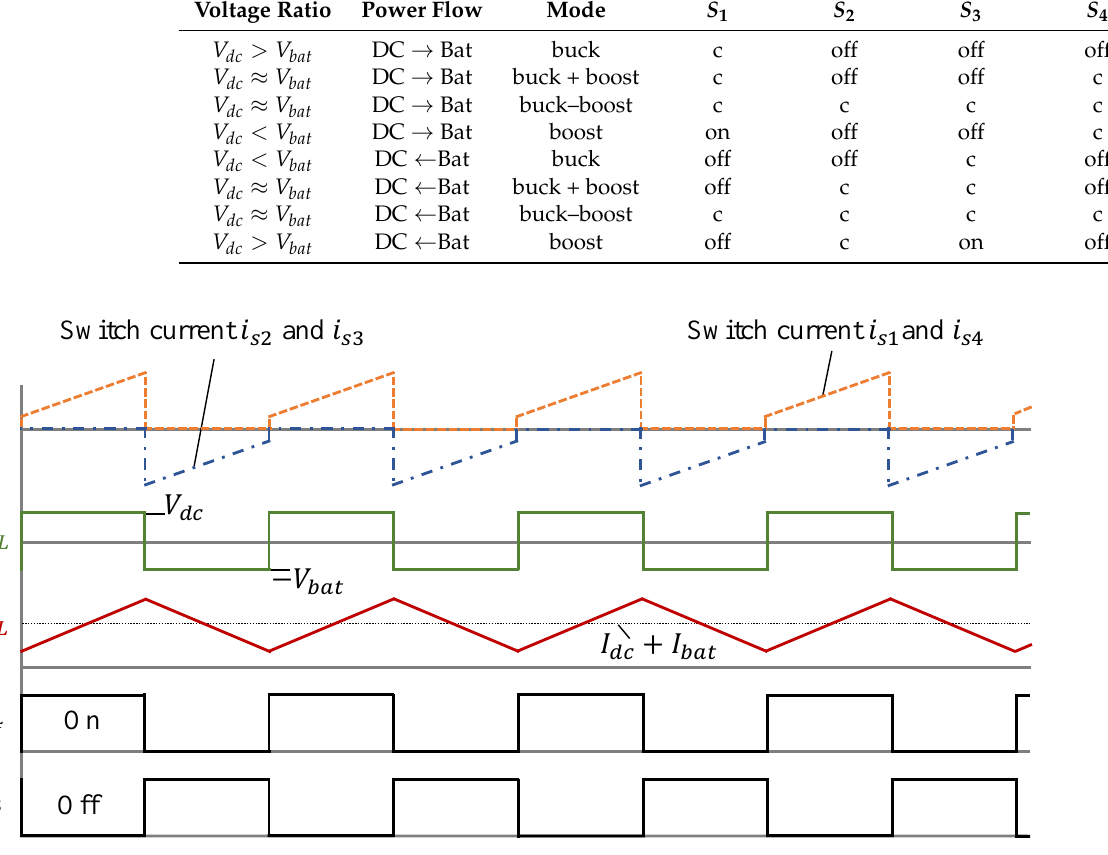
Figure 4. Characteristic of the inductor current and voltage in buck–boost